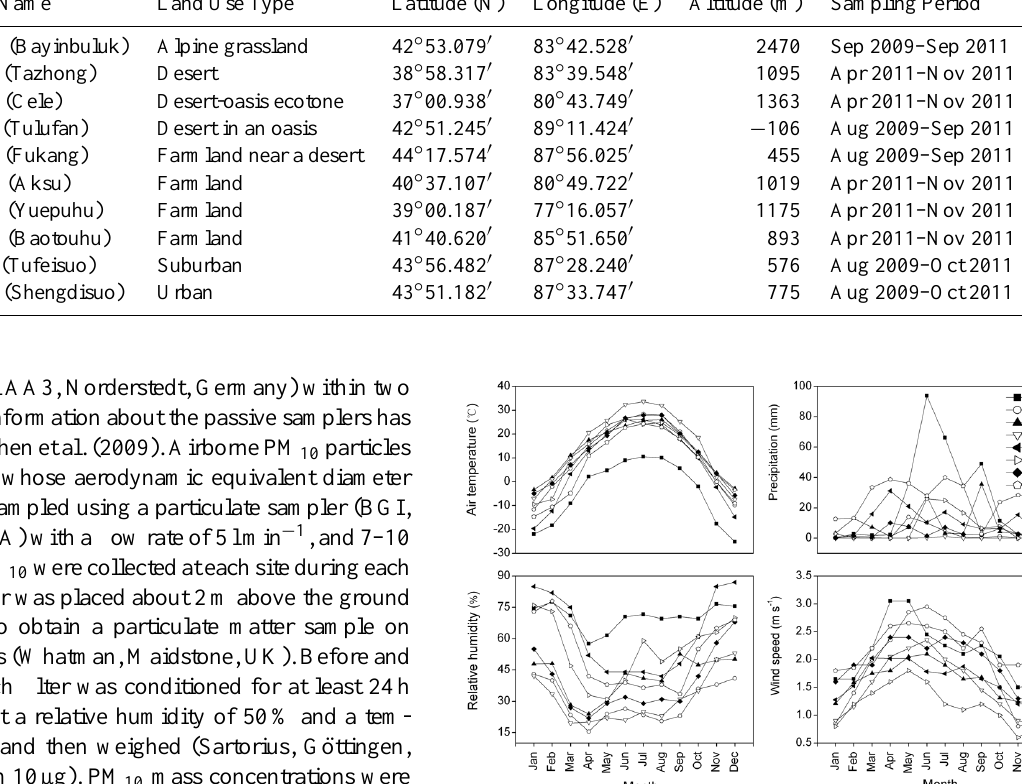
Table 1. Characteristics of the ten monitoring sites in the Xinjiang arid region of northwest China. Site No.